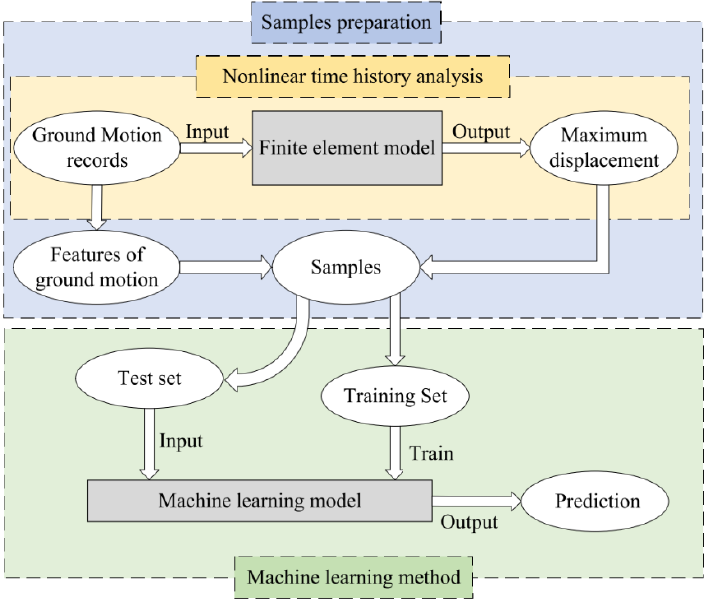
Figure 1. Analysis procedure of the proposed method.